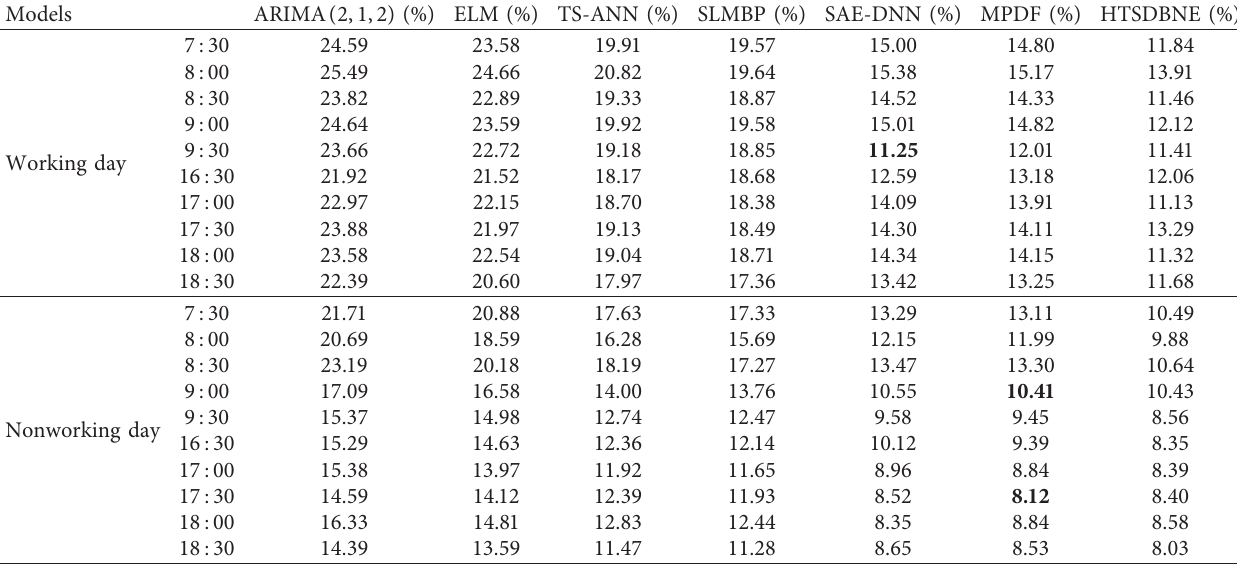
Table 8: Comparison between HTSDBNE and other models (MAPE) (station 8 of line 10). Models